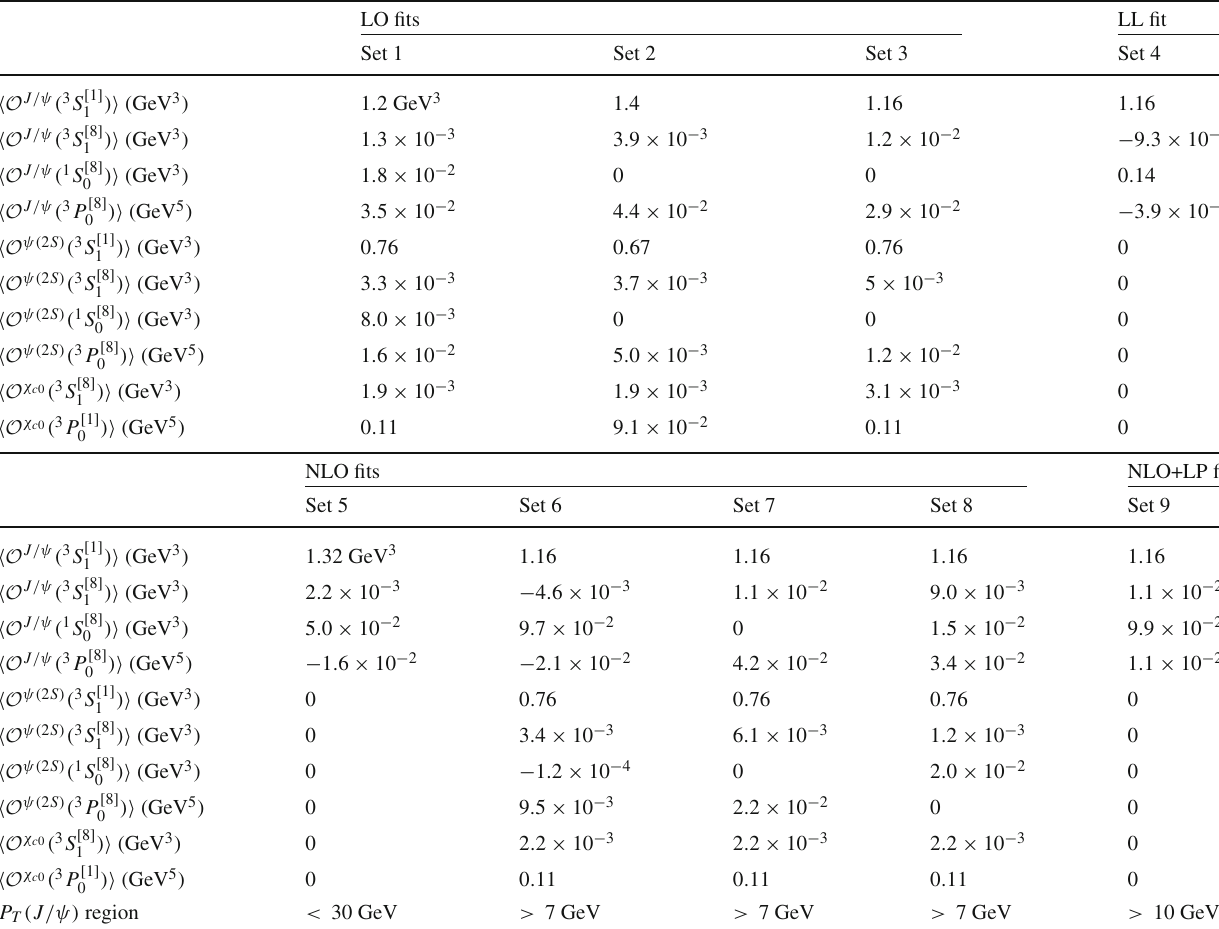
Table 3 Summary of LDMEs we used from various fits [Set 1: Sharma et al. [64]; Set 2: Braaten et al. [61]; Set 3: Krämer [65]; Set 4: Sun et al. [66]; Set 5: Butenschön et al. [67]; Set 6 : Gong et al. [68]; Set 7: Shao et al. [69]: Set 8: Han et al. [70]: Set 9: Bodwin et al. [71]] LO fits LL fit Set 1 Set 2 Set